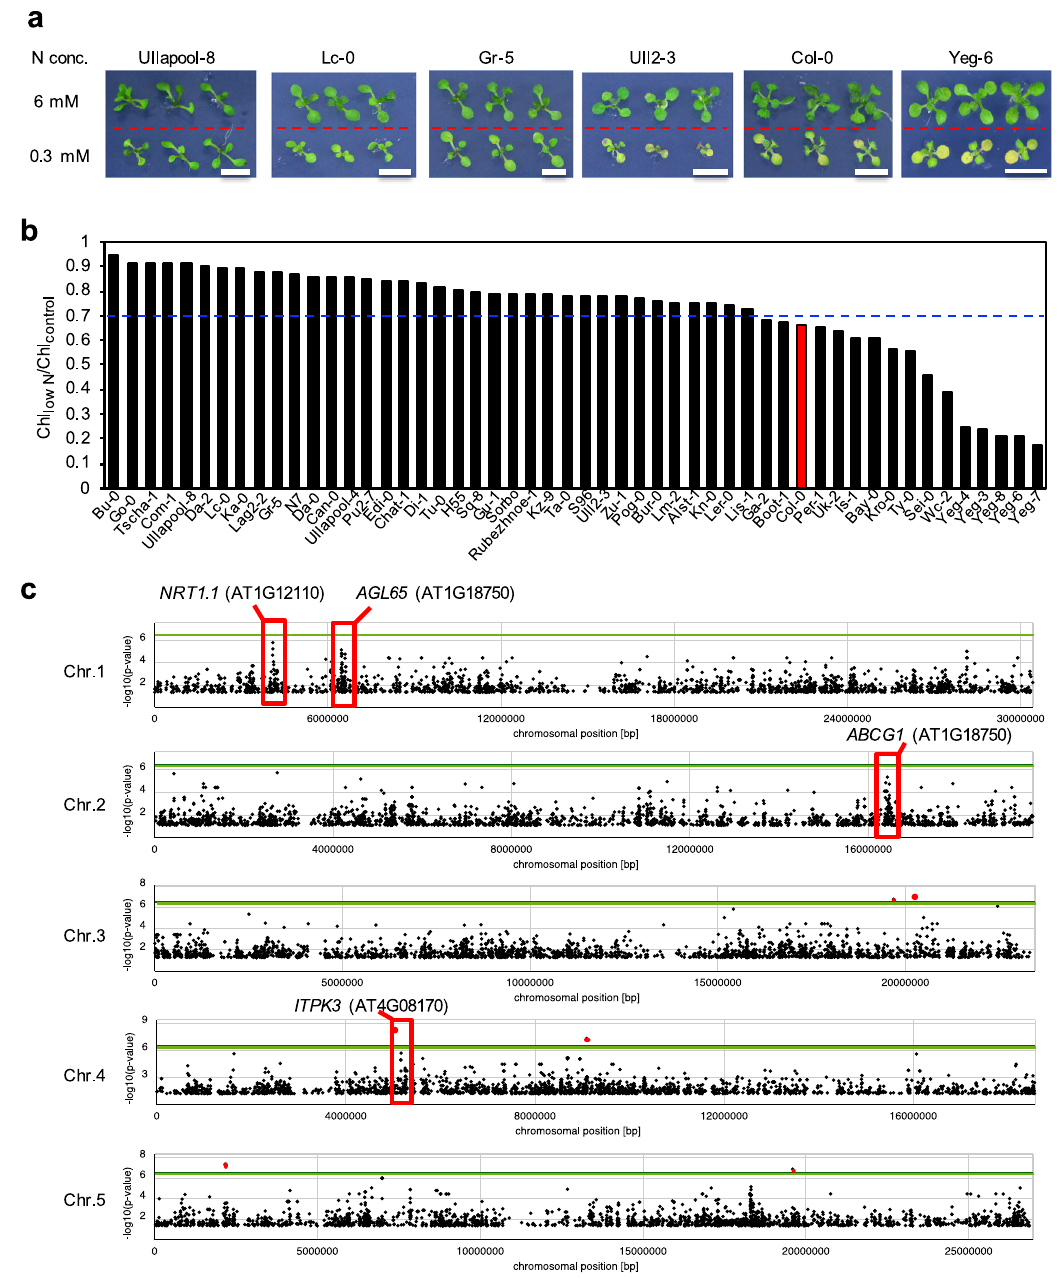
Fig. 1 Differences in N de fi ciency responses among 52 Arabidopsis thaliana accessions. a Images showing the different N de fi ciency responses of Arabidopsis accessions. Seedlings of Ullapool-8, Lc-0, Gr-5, Ull2-3, Col-0 and Yeg-6 were grown with continuous light for 5 days on 1/2 MS agar plates and then for 7 days on modi fi ed 1/2 MS agar plates that contained 2 mM KNO 3 and 2 mM NH 4 NO 3 (6 mM N; control N treatment), or with 0.1 mM KNO 3 and 0.1 mM NH 4 NO 3 (0.3 mM N; low N treatment) as N sources. Scale bar = 1 cm. b Ratios of total chlorophyll content of seedlings grown under the low N condition (Chl low N ) to that of seedlings grown under the control N condition (Chl control ). The shoots of 12-day-old seedlings of 52 accessions grown with continuous light were analyzed. The Chl low N /Chl control ratio was calculated with means of Chl low N and Chl control obtained with fi ve biological replicates (Supplementary Table 1). Red bar indicates the Chl low N /Chl control ratio of Col-0, which was used as a reference accession in this study. The blue dotted line indicates the average Chl low N /Chl control ratio of all 52 accessions. Values of chlorophyll contents are shown in Appendix Table S1. c Genome-wide association study (GWAS) of Arabidopsis accessions using Chl low N /Chl control values. In Manhattan plots, horizontal green lines indicate the signi fi cant genome-wide threshold ( p- value = 5 × 10 − 6 ), while gray lines correspond to – log 10 ( p- values) of 2, 4 and 6. Peaks consisting of single nucleotide polymorphisms (SNPs) located in the vicinity of the NRT1.1 , AGL65 , ABCG1 or ITPK3 locus are marked with a red rectangle. SNPs with a p- value smaller than 5 × 10 − 6 are indicated by red dots.